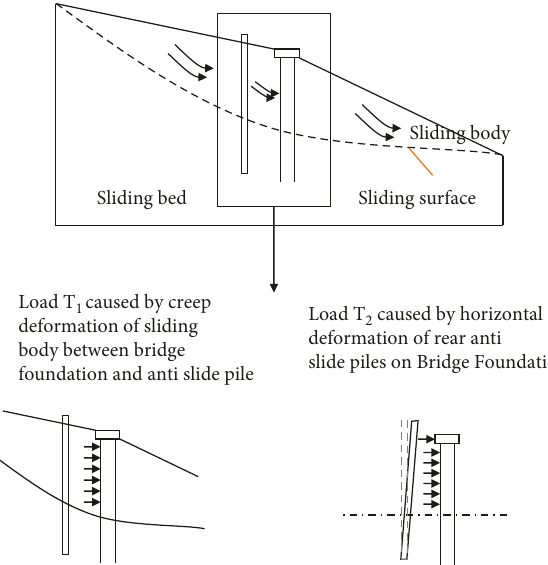
Figure 13: Schematic diagram of stress of bridge foundation in landslide reinforced by antislide piles.